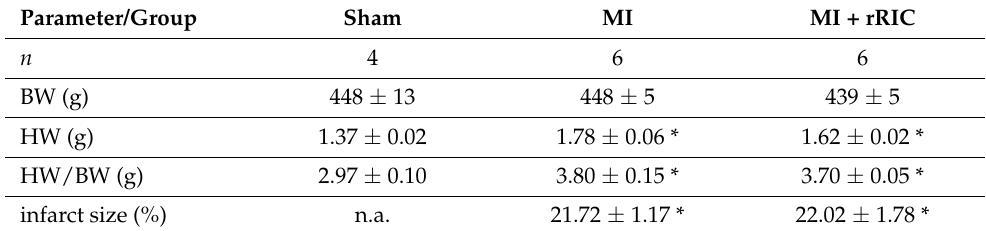
Table 1. Characteristics of the experimental